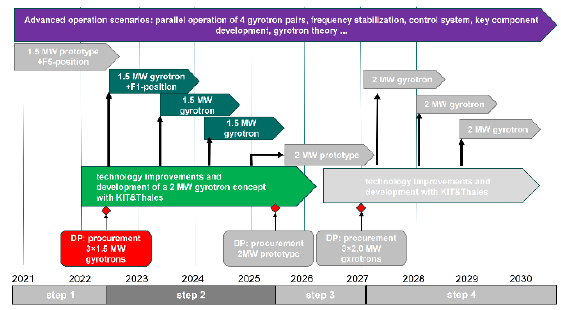
Fig. 2. Four Step Strategy for the ECRH-upgrade at W7-X. Step 1 and step 2 are already approved.